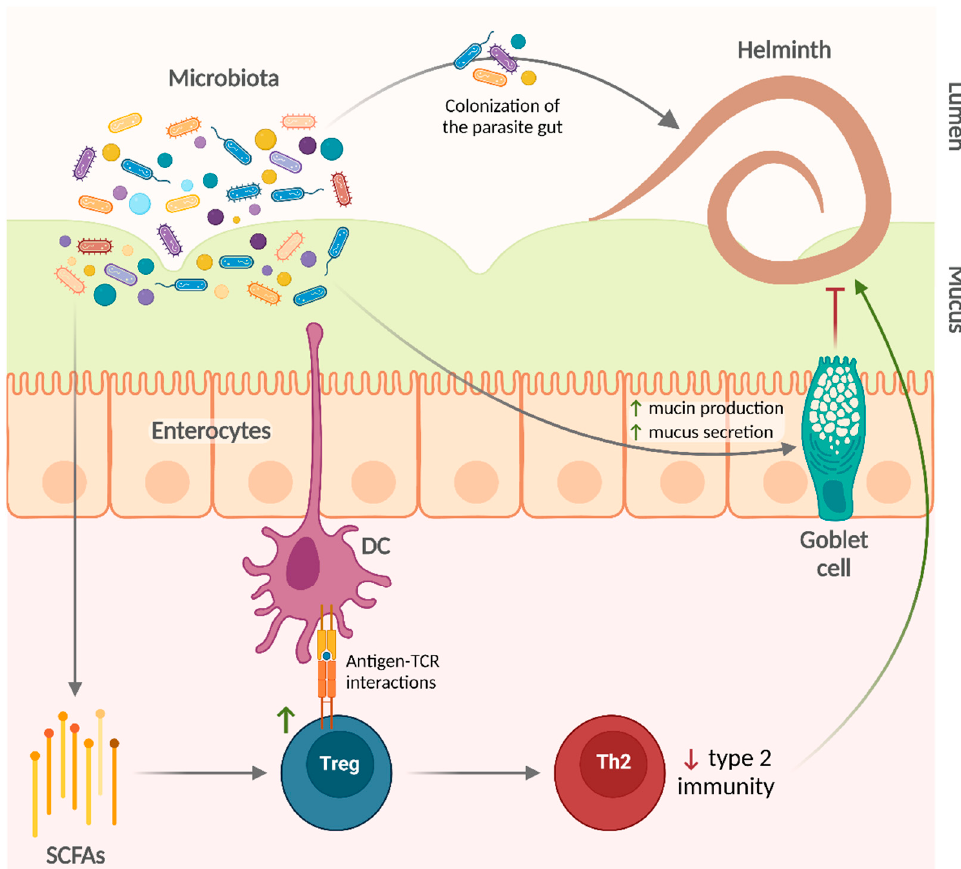
Figure 2. Mechanisms underlying the effects of the microbiota on helminth infections. Commensal bacteria can favor the establishment of helminth infections or enhance worm expulsion through different mechanisms. In addition, the helminth gut is colonized by bacteria from the host microbiota, from which it forms its own. DC, dendritic cell; SCFAs, short-chain fatty acids; TCR, T cell receptor; Th2, type 2 helper T cell; Treg, T regulatory cell.